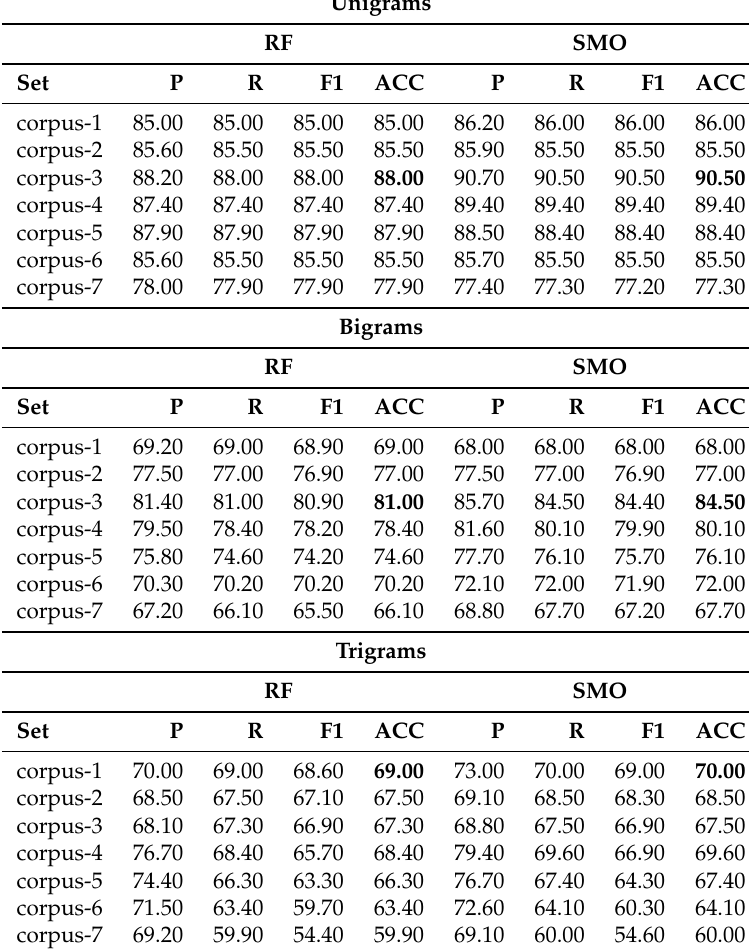
Table 3. Performance of unigrams, bigrams and trigrams for the word-gram model.